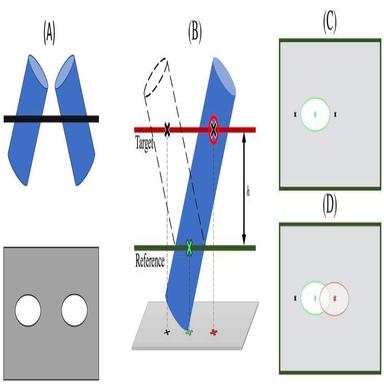
Schematic showing (A) the ambiguity of the out-of-plane angle θ, (B) successive polishing to determine the sign of θ, (C) the reference image with the two predicted centroid positions, and (D) the reference image and target image schematically overlaid to determine the sign of θ.